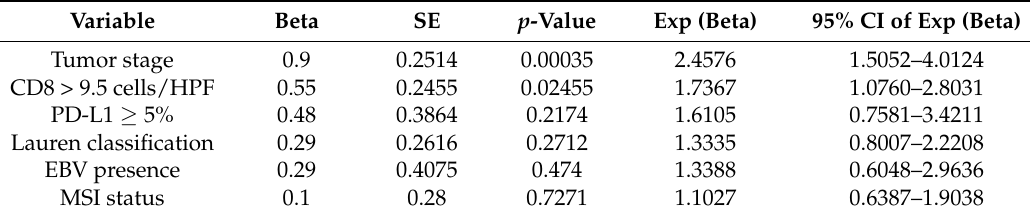
Table 4. Multivariate analysis of survival probability.